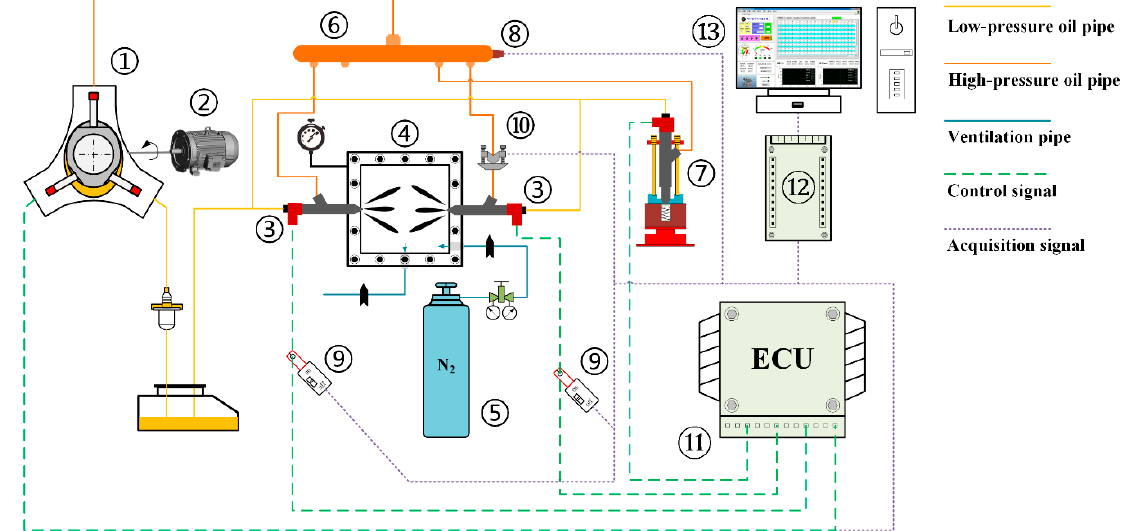
Figure 3. Schematic of experimental apparatus for CRS test bench. ① Fuel pump, ② electrical motor, ③ injectors, ④ chamber, ⑤ N 2 container, ⑥ common rail pipe, ⑦ single-injection instrument, ⑧ pressure sensor (100 Hz), ⑨ current clamp, ⑩ pressure sensor (100 kHz), ⑪ electronic control unit (ECU), ⑫ data acquisition card, ⑬ host computer.